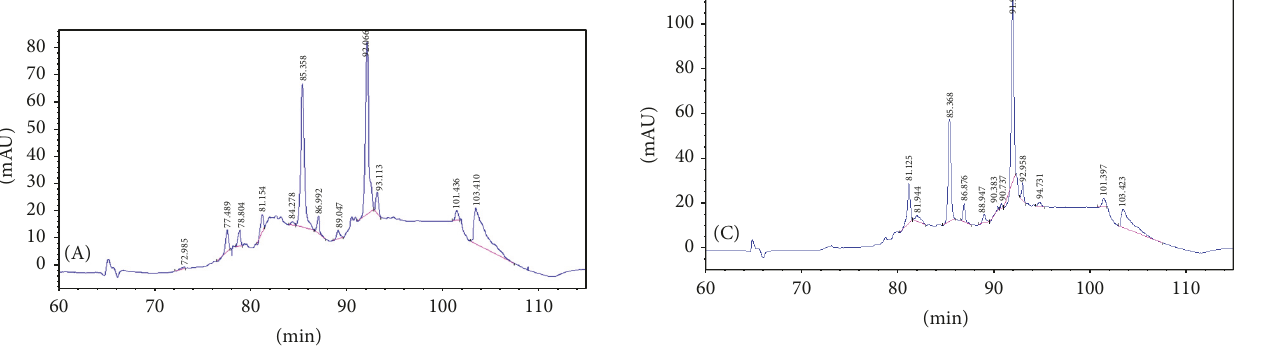
Figure 4: The peaks of peptides in the serum of asthma model